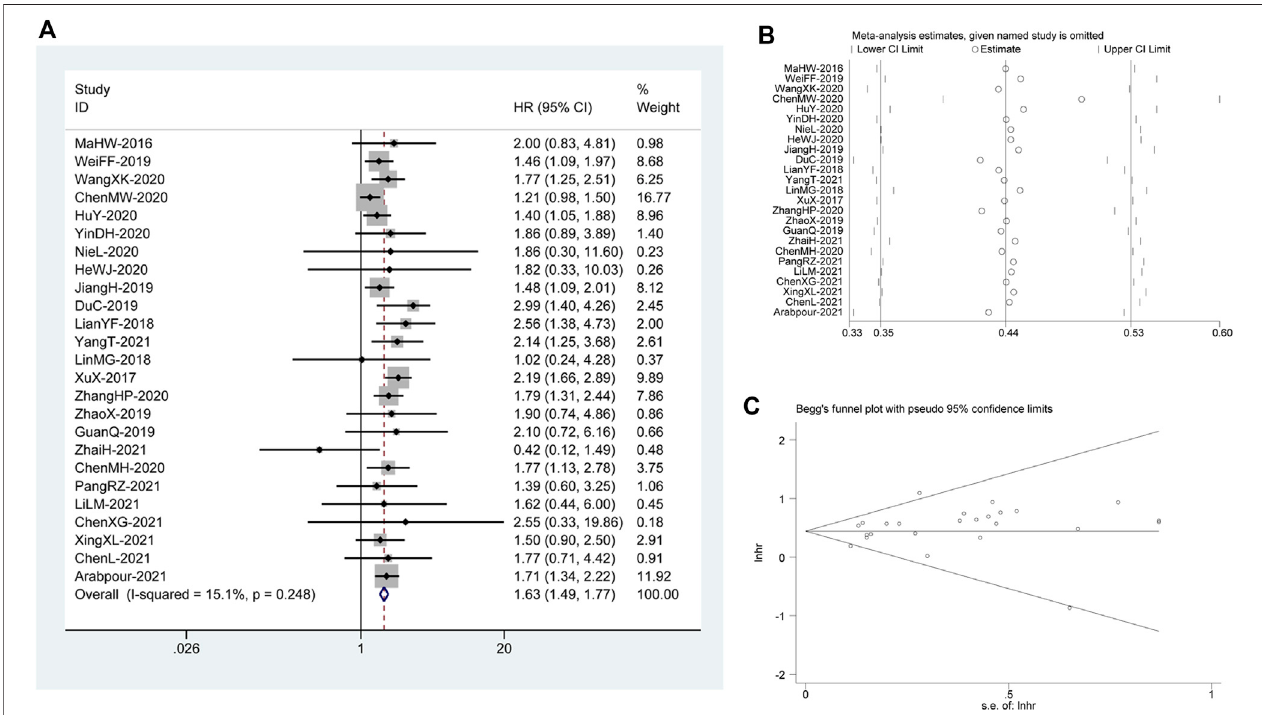
FIGURE1|(A) Forestplotre fl ectingtheassociationbetweenOSand DUXAP8 expressionlevelincancer. (B) Sensitivity analysisforstudiesaboutOS. (C) :Begg ’ s funnel plot of DUXAP8 for overall survival.